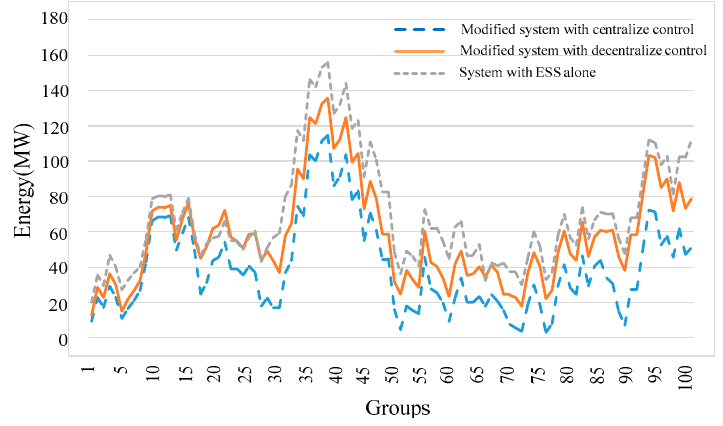
Figure 31. A comparison of results of storage energy between the modified system adopting centralized control as well as the decentralized control and the system with ESSs alone.